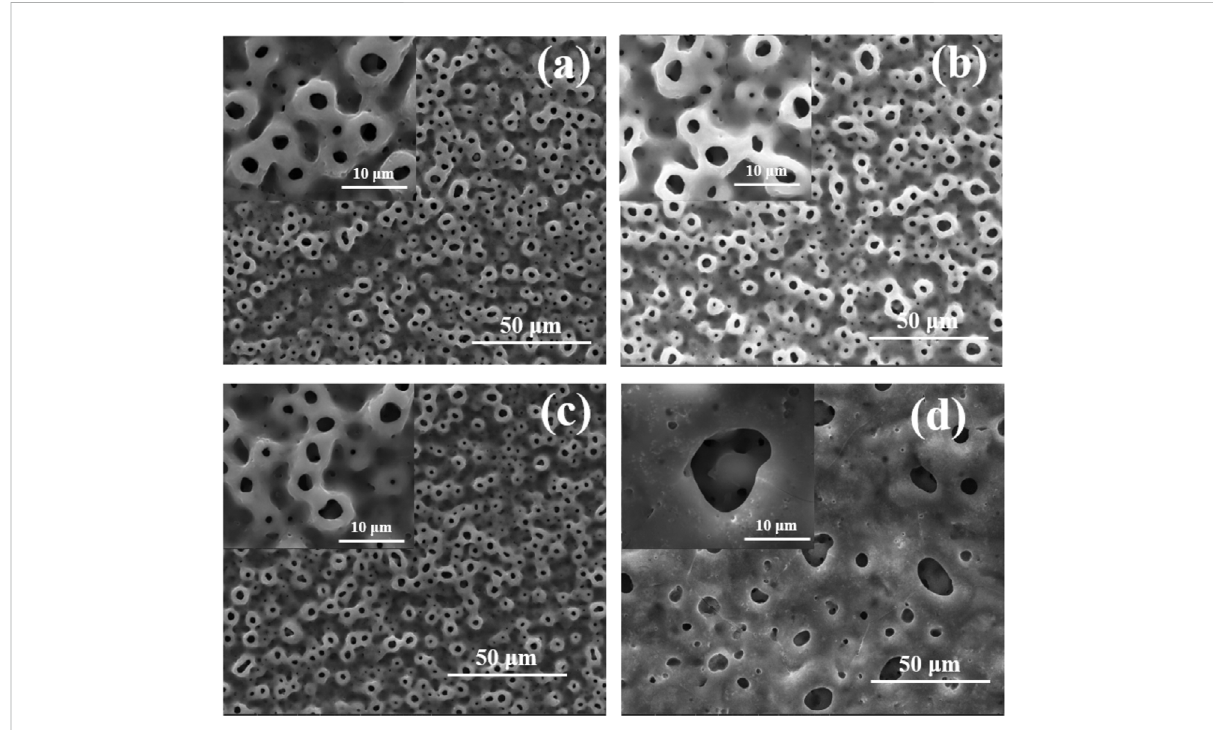
FIGURE 1 Surface morphologies of different coatings: (A) 0Cu-MAO, (B) 0.5Cu-MAO, (C) 1Cu-MAO, (D) 2Cu-MAO.